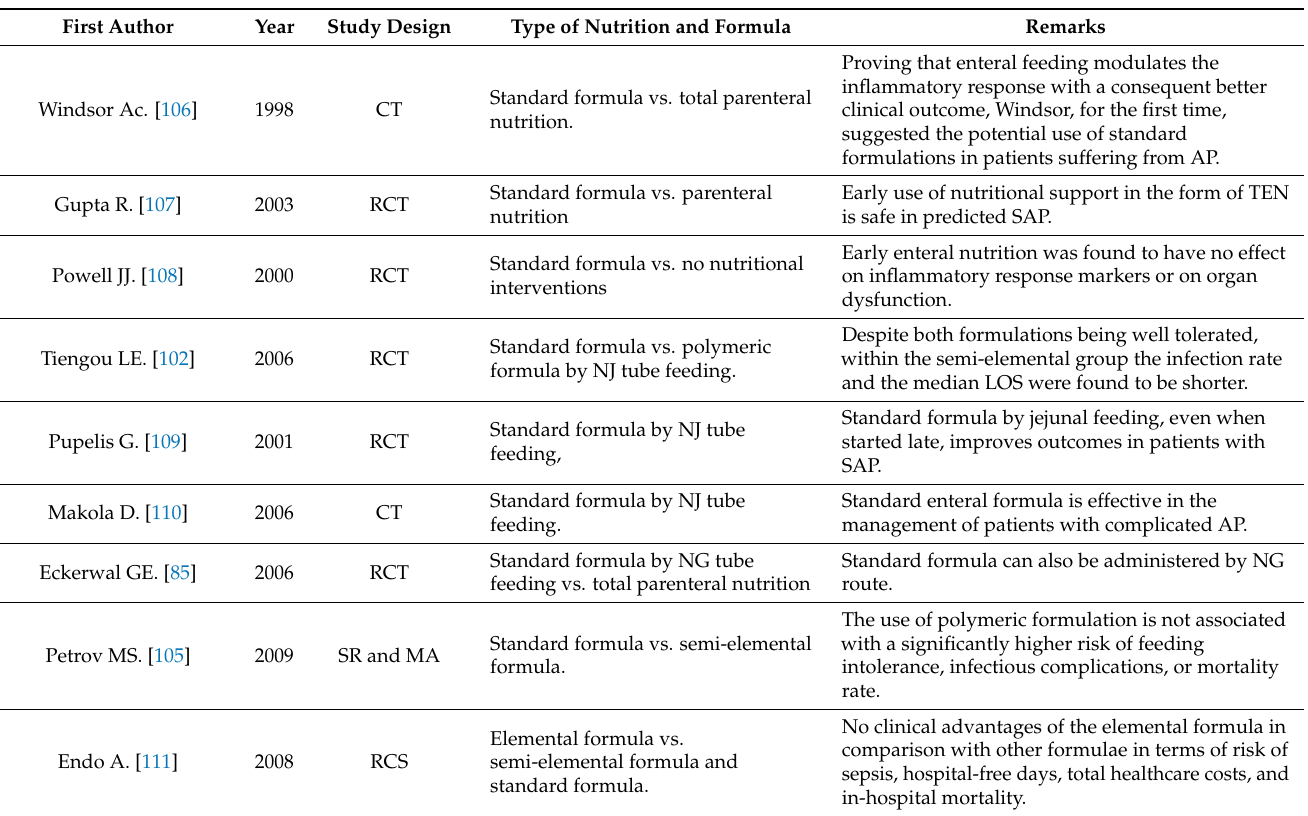
Table 2. Evidence regarding the optimal composition of enteral feeding (elemental, semi-elemental, or standard in acute pancreatitis.